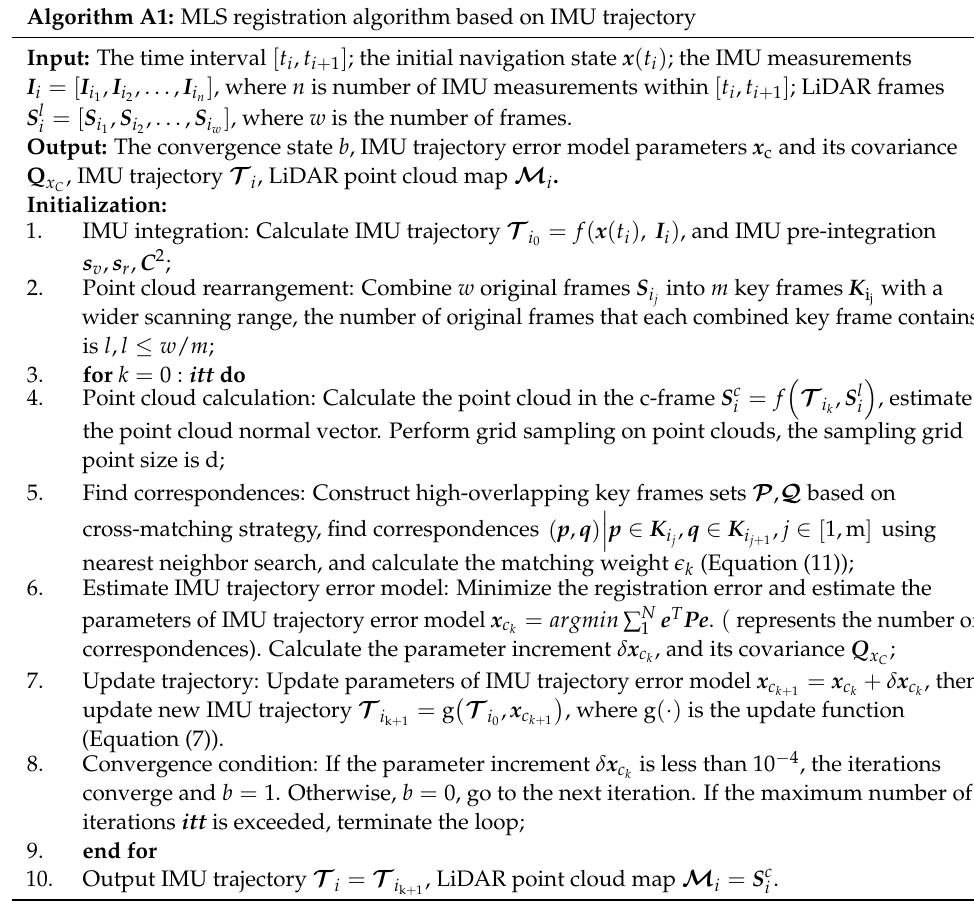
Algorithm A1: MLS registration algorithm based on IMU